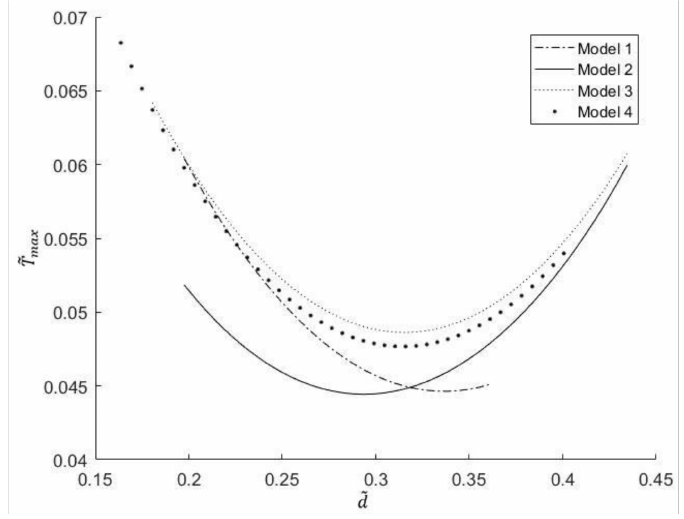
Figure 4. The relationship between (cid:101) T max and (cid:101) d of four models at ϕ = 15% and N =